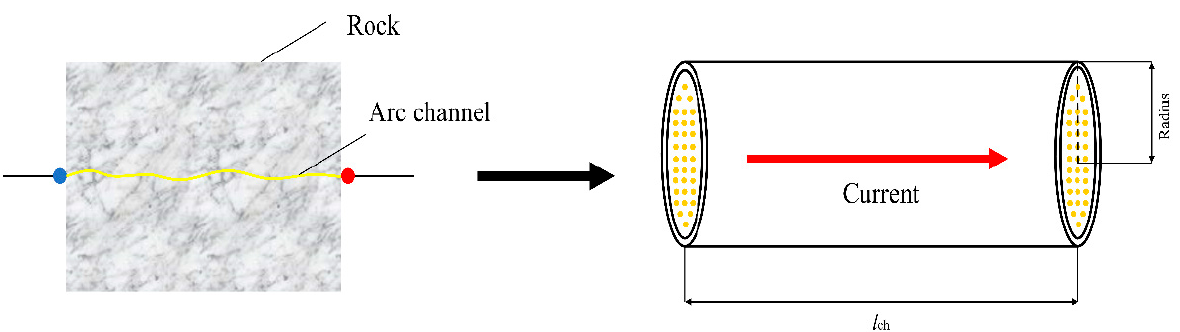
Figure 5. The cylindrical plasma arc channel model in the rock.